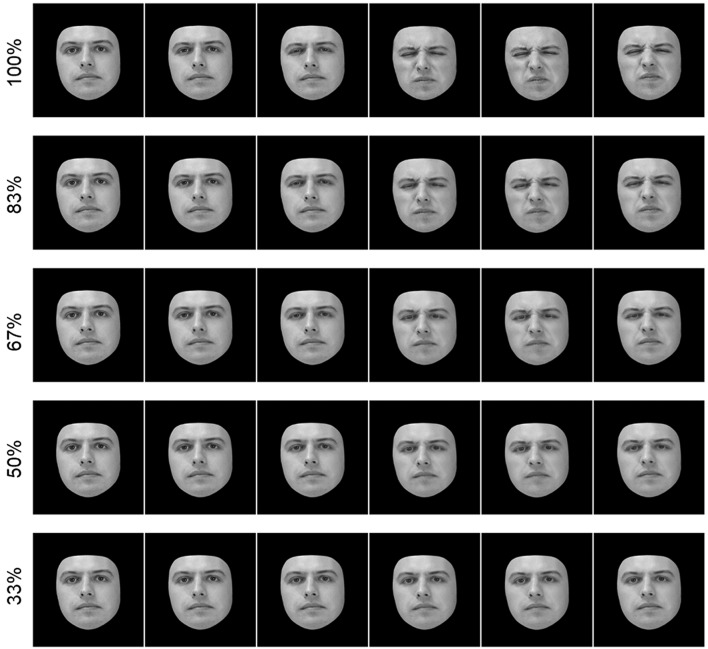
The image above shows partial image sequences (every other frame) from five video stimuli ranging in intensity of emotion. The top video shows the original video of an individual's face changing from neutral to an expression of disgust. This video was then morphed with the neutral face frame (leftmost frame) to reduce the intensity of the final expression (rightmost frame). Emotional intensity ranged from 100% (unedited video) to 33% intensity.